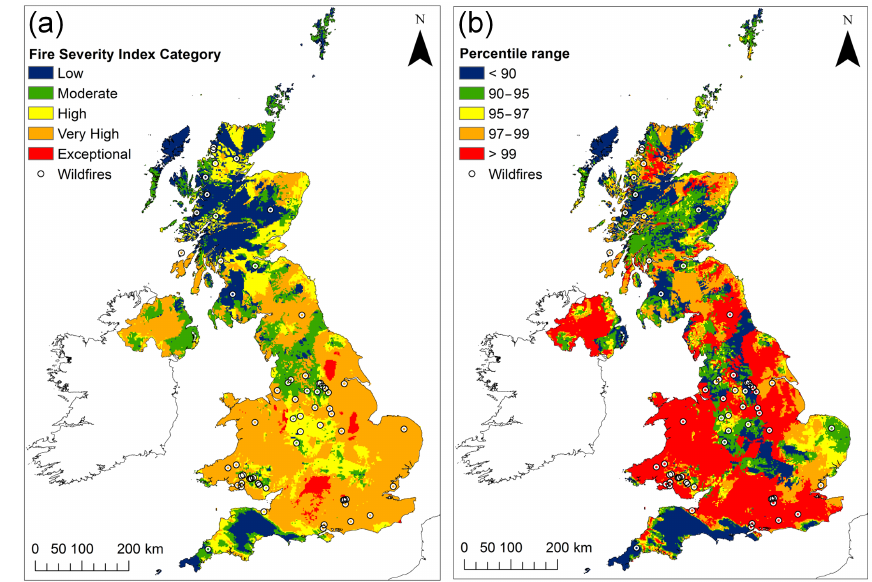
Figure 7. Fire danger in the UK, mapped for 2 May 2011, based upon the midnight 12h NWP-derived FWI component forecast, classified using (a) the existing Met Office Fire Severity Index (MOFSI) (Kitchen et al. 2006; Met Office, 2005) and (b) the percentile-based FDRS described herein. This date coincides with the height of a period of extreme wildfire activity seen across Great Britain in spring 2011, related to weather conditions extremely conducive to vegetation fire spread, with 66 wildfires reported in the Fire and Rescue Service Incident Recording System (IRS) as burning in mainland Britain on 2 May 2011. These incidents are shown as hollow circles on both maps. No fire data for Northern Ireland are recorded in the IRS. In (a) the most extreme FWI conditions are confined to relatively small regions of England, whereas in (b) the most extreme conditions are much more widespread and are found across the entire UK, as is the fire activity.